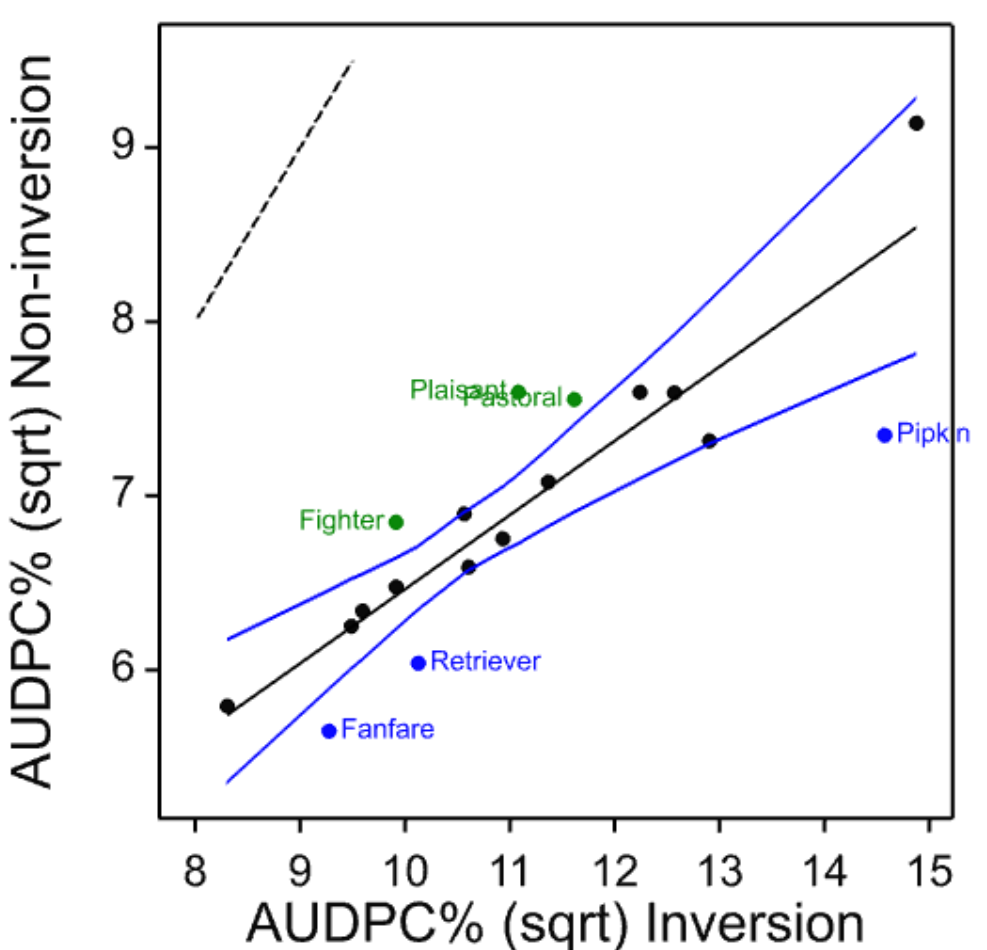
Figure 8. Regression of non-inversion on inversion %AUDPC (sqrt) for 18 winter barley cultivars in the 2011–2014 trials. The blue lines show the 95% confidence interval of the regression line (solid black), while the dashed line shows the 1:1 yield ratio. Only cultivars outside the confidence limits are labelled for clarity. Table 6. Ranking of 18 winter barley cultivars grown from 2011 to 2014 by the difference between their inversion and non- Table 7. Absolute %AUDPC (sqrt) rank differences for combined 2011–2014 trials. Number of cultivars shows the number of cultivars with the given rank change and Cumulative shows the number with that rank change or greater. The 50%, 90% and 95% points are from the simulated variables and show the distribution of the number of cultivars that exhibited an absolute rank change at least as large as that specified due to random variation, as described in the text. Rank No. Cumulative 50% 90% Change Cultivars